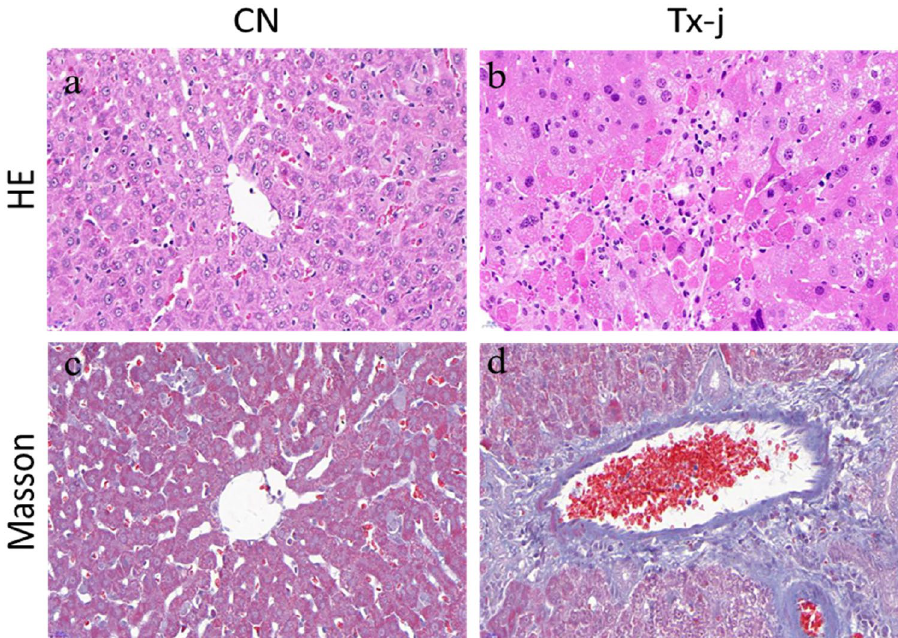
Figure 1. Haematoxylin and eosin staining in the control group showed clearly structured hepatic lobules, and the hepatocytes were stationary in the centre; veins radiated throughout the tissue, and the central veins, the arteriovenous structure, and the bile duct appeared normal. In the model group, there was extensive necrosis of hepatocytes and normal hepatic lobule structure disappeared; a large amount of inflammatory cell infiltration was evident. Masson staining showed that, in the control group, only a few collagen fibres were found in the manifold area and central vein. The liver tissue of the model group had extensive hyperplasia, extending from the manifold area to the surrounding area, forming a complete pseudolobular structure of different